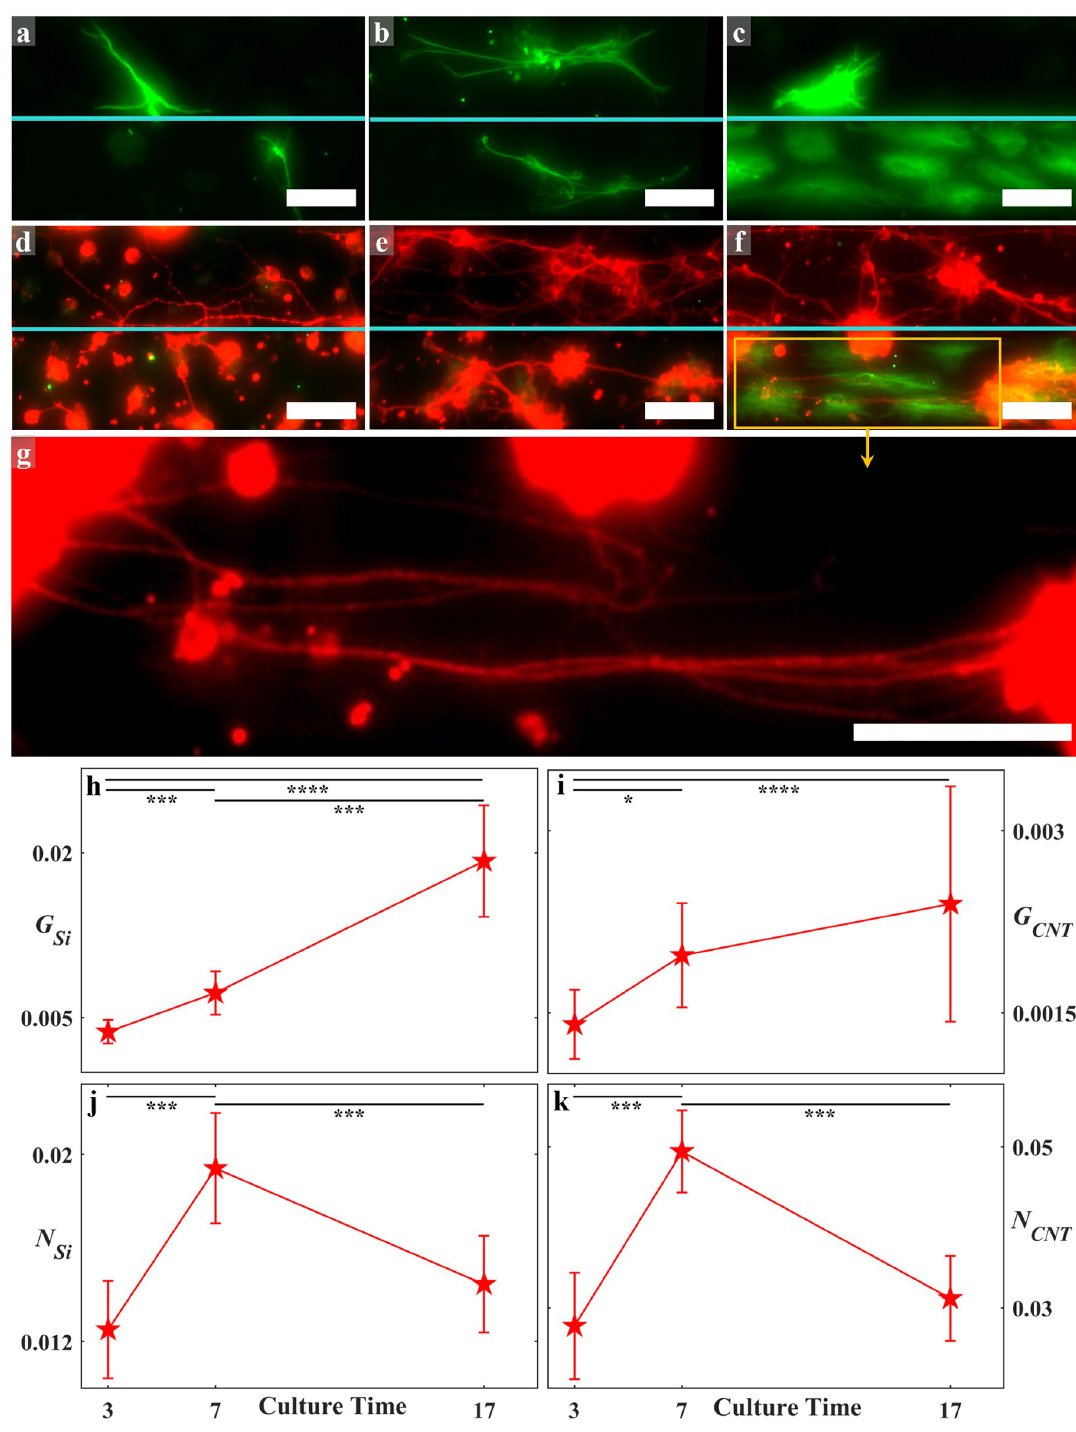
Fig 4. Examples of fluorescence images of retinal cells interacting with the Euclidean electrodes at all culture times (green = GFAP labelled glia; red = β -tubulin III labelled neurons). (a, b, c) GFAP labelled glial cells (green) on the VACNT and SiO 2 gaps of S75C75 electrodes at 3 DIV (a), 7 DIV (b) and 17 DIV (c). (d, e, f) Merged fluorescence images of neural networks showing GFAP labelled glia (green) and β -tubulin III labelled neurons (red) on different regions of the same electrodes shown in (a), (b), and (c). Panel (g) is a zoom-in on the region marked in (f) with the green channel removed in order to clearly highlight neuronal processes bundling in the SiO 2 gap. Scale bars are 50 μ m in (a) through (g). The cyan lines mark the edge between the VACNT electrode (top half) and SiO 2 gap